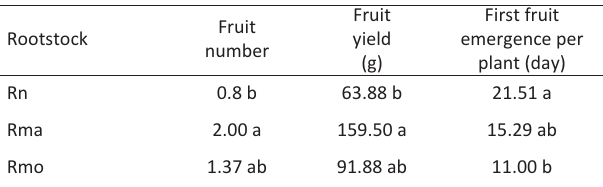
Table 4 ­ The effect of rootstock on some characteristics of cucumber